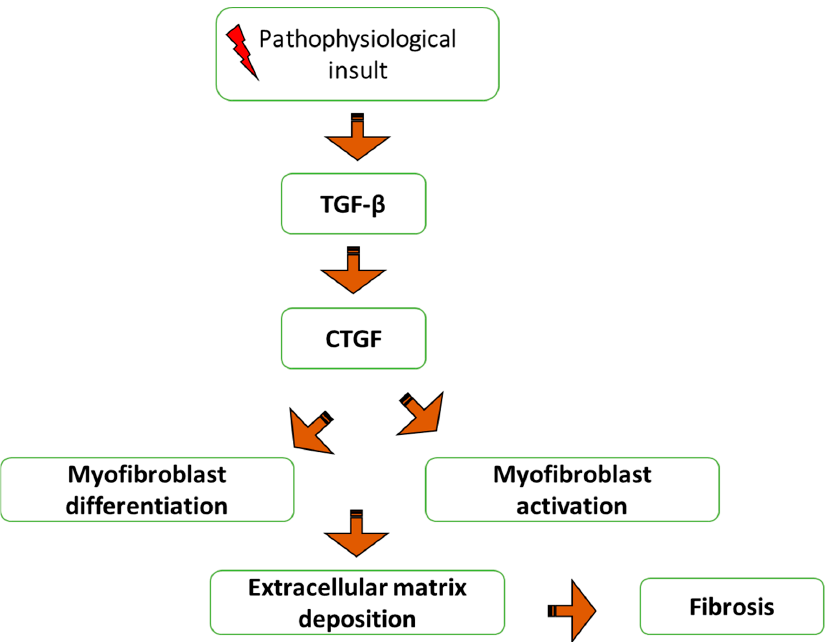
Figure 5. The regulatory scheme for CTGF and its role in fibrosis. TGF- β ; transforming growth factor-beta, CTGF; connective tissue growth factor.